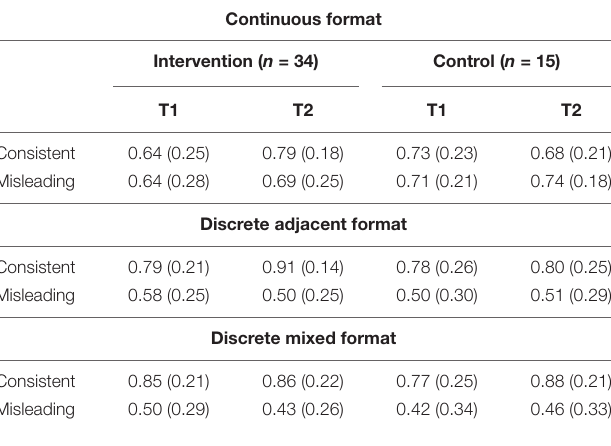
TABLE 1 | Mean ( SD ) performance across each format of the Spinners task by